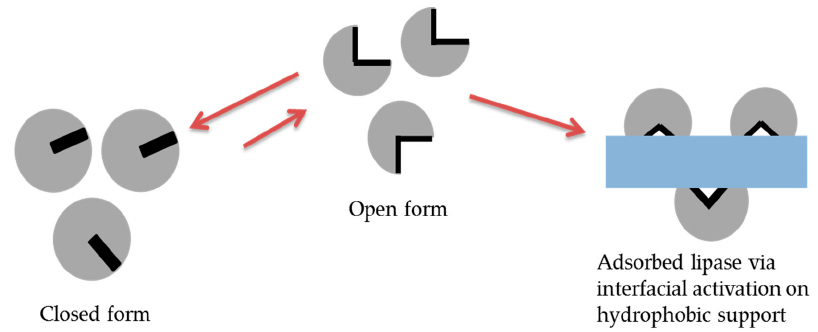
Figure 2. Scheme of immobilization by interfacial activation on a hydrophobic support.